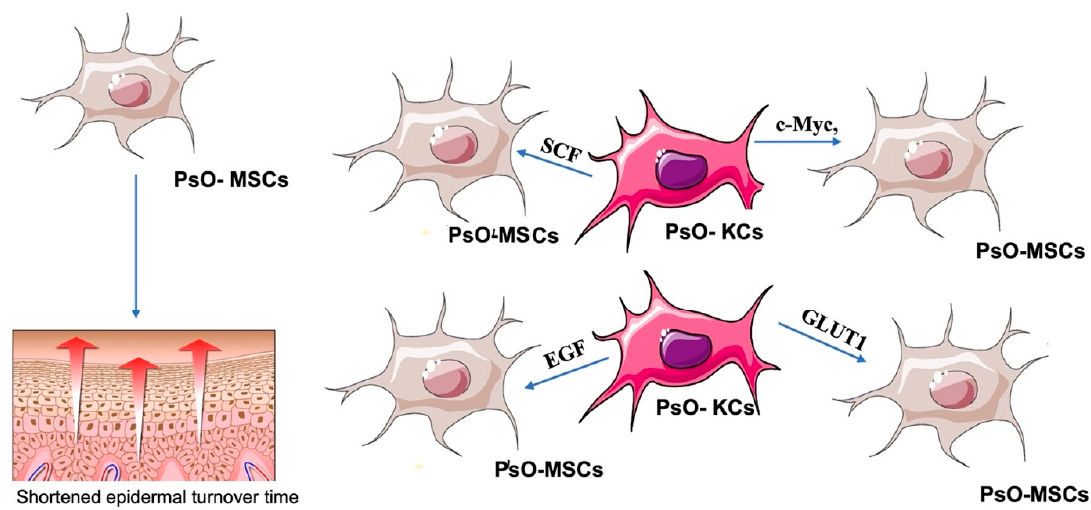
Figure 2. Cross-talking between PsO-MSCs and PsO-KCs: High levels of pro-inflammatory cytokines secreted by MSCs induce KCs proliferation, shortening the epidermal turnover time through secretion of several cytokines including Epidermal Growth Factor (EGF). PsO-KCs co-cultured with control MSCs upregulates the expression of c-Myc, GLUT1, SCF, and EGF, resulting in enhanced metabolism and increased proliferation of MSCs, establishing a vicious